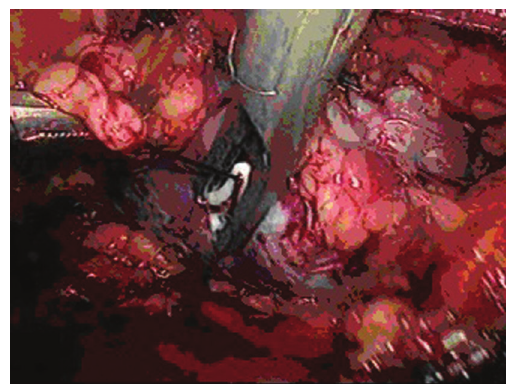
Figure 2 - Hem-o-lock close at the end of